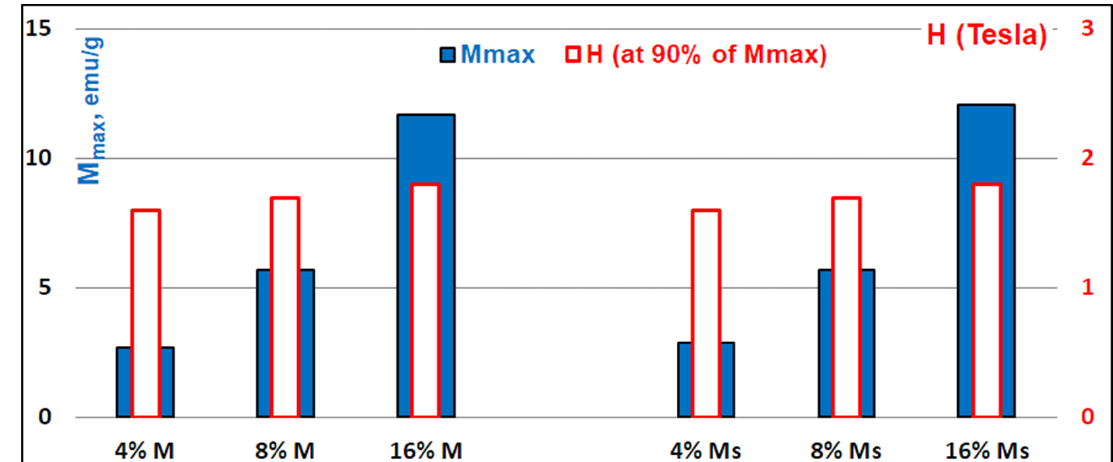
Figure 14. Comparative magnetic features of PLA − magnetite nanocomposites filled with 4–16% untreated (M) and surface treated (Ms) magnetite nanoparticles: M max and H at 90% of M max .